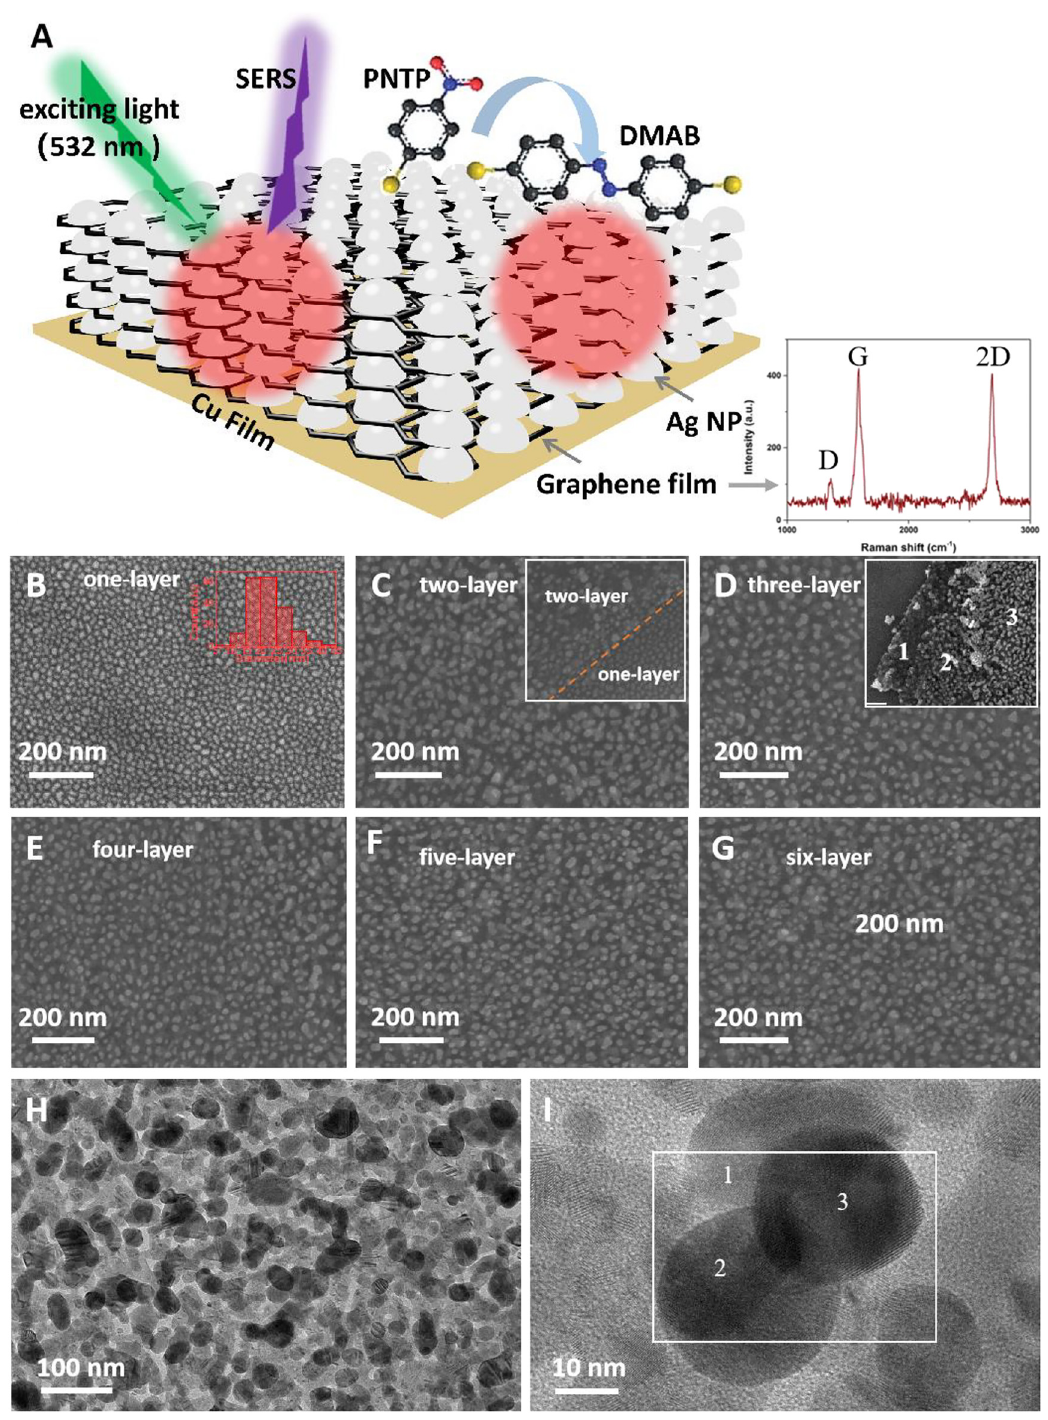
Figure 1: (A) the schematic illustration of the surface-enhanced Raman spectroscopy (SERS) and surface plasmon-driven reaction on the MAgNP-CuF substrates. (B) – (G) scanning electron microscopy (SEM) images of MAgNP-CuF with different layers. The inset in (B) exhibits the size distribution of Ag NP. The inset in (C) exhibits the boundary region between one- and two-layer structures. The inset in (D) exhibits the boundary region of three-layer structure. (H) and (I) transmission electron microscopy (TEM) and high-resolution transmission electron microscopy (HRTEM) images of the three-layer MAgNP